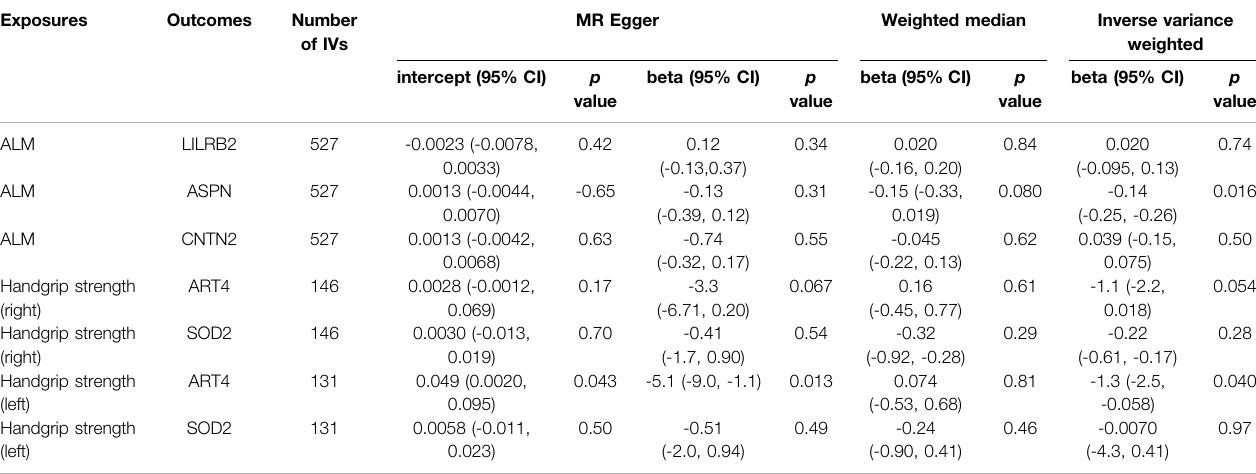
TABLE 8 | Mendelian randomization estimates of sarcopenia-related traits on plasma proteins.